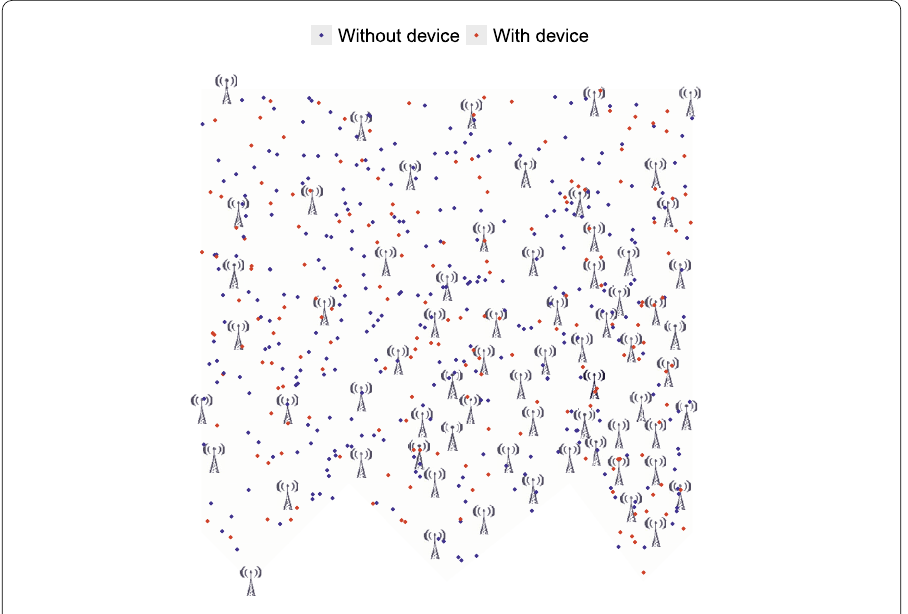
Figure 2 Network configuration. Positions of 70 BTS (67 omnidirectional radio cells –in grey– and 3 directional radio cells – in black), positions of individuals at time t = 0. (See complementary online material for an animated gif for the displacement of individuals